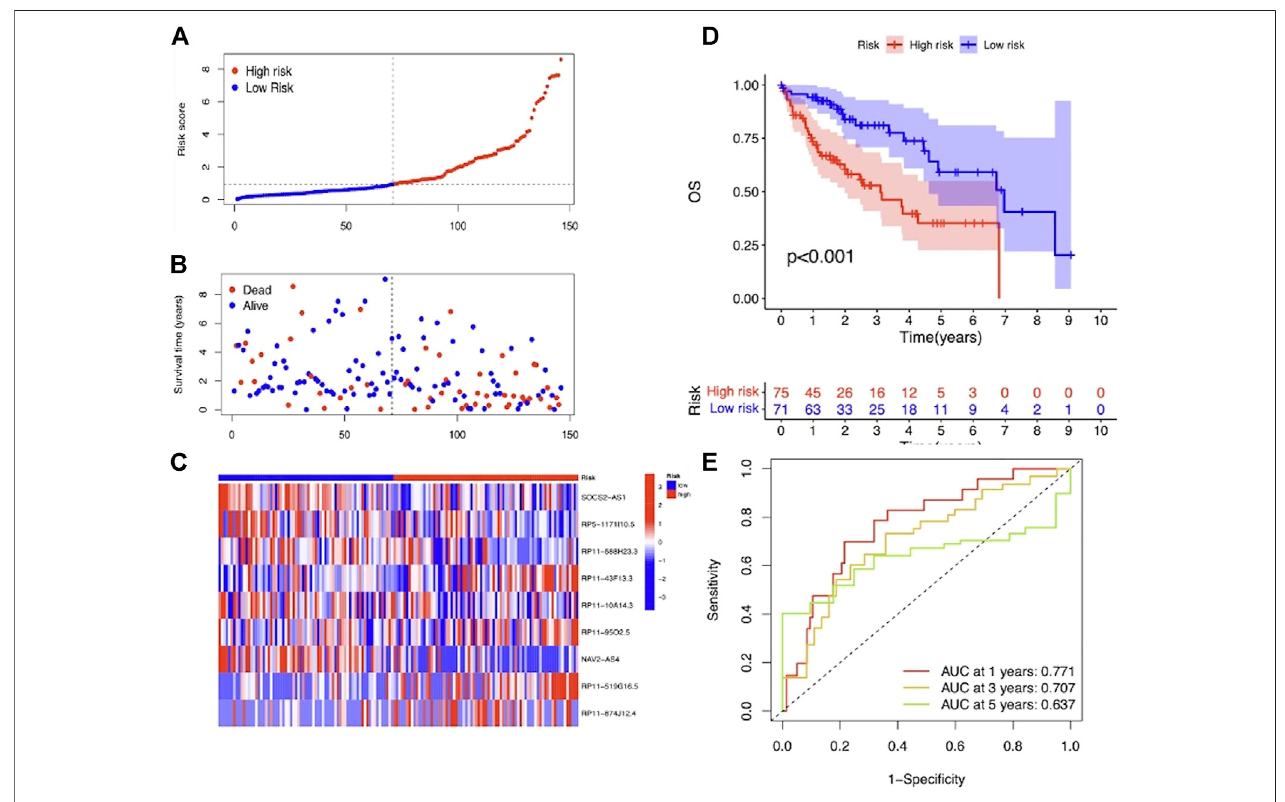
FIGURE 5 | Prognostic value of the 9-m7G-related-lncRNA risk model between the two groups in the testing set. (A) Distribution of the risk score (the x-axis representedtheLIHCpatientsarrangedaccordingtotheriskscore,andthey-axisrepresentedvaluesoftheriskscoreforeachpatient). (B) Scatterplotofsurvivalstatus and riskscore(the x-axis represented the LIHC patients arranged according tothe risk score, and the y-axis represented thesurvivaltimeofeach patient). (C) Heatmap oftheexpressionpro fi leofthe9m7G-relatedlncRNAs. (D) KMcurvesdisplayedtheOSofLIHCpatientsbetweenhigh-andlow-riskgroups. (E) ROCcurvesofthe risk model of 1, 3, and 5 years for OS.